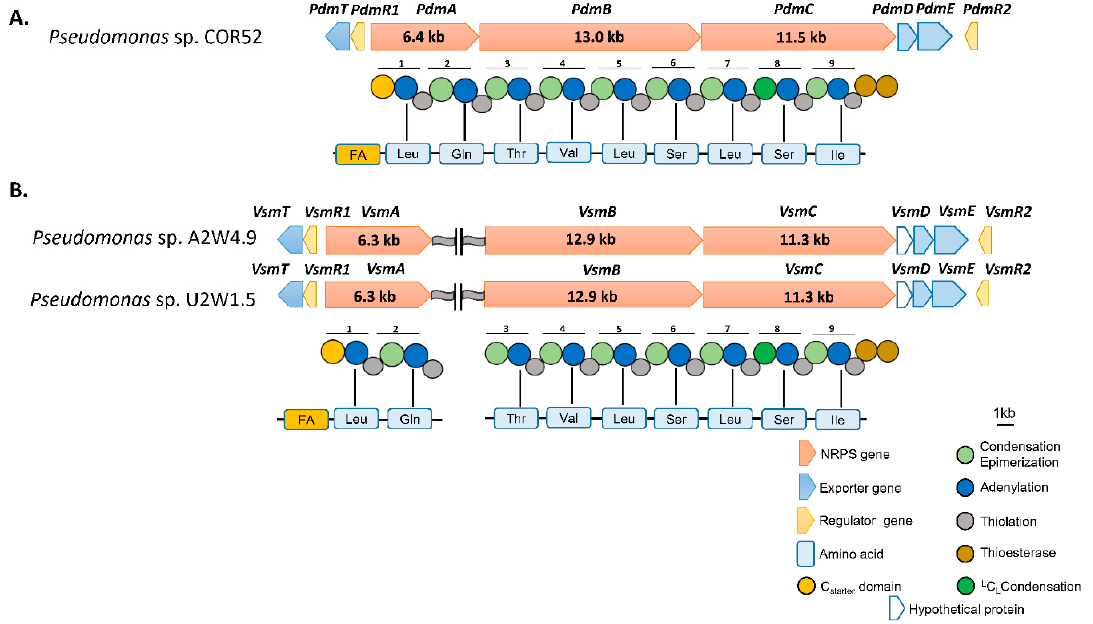
Figure 2. Organization of the pseudodesmin and viscosinamide biosynthetic gene clusters (BGCs). ( A ) The pseudodesmin gene cluster of Pseudomonas sp. COR52 comprises three non-ribosomal peptide synthetase (NRPS) genes, pdmA , pdmB and pdmC , in an operon-like organization. ( B ) The viscosinamide gene clusters of Pseudomonas spp. A2W4.9 and U2W1.5 comprise three NRPS genes, of which the initiatory NRPS gene, vsmA , is located distantly from the other two NRPS genes, vsmB and vsmC . The predicted peptide sequence is based on the substrate specificity of the nine modules that were derived from the in silico and phylogenetic analysis of the corresponding A domain sequences. FA: fatty acid.